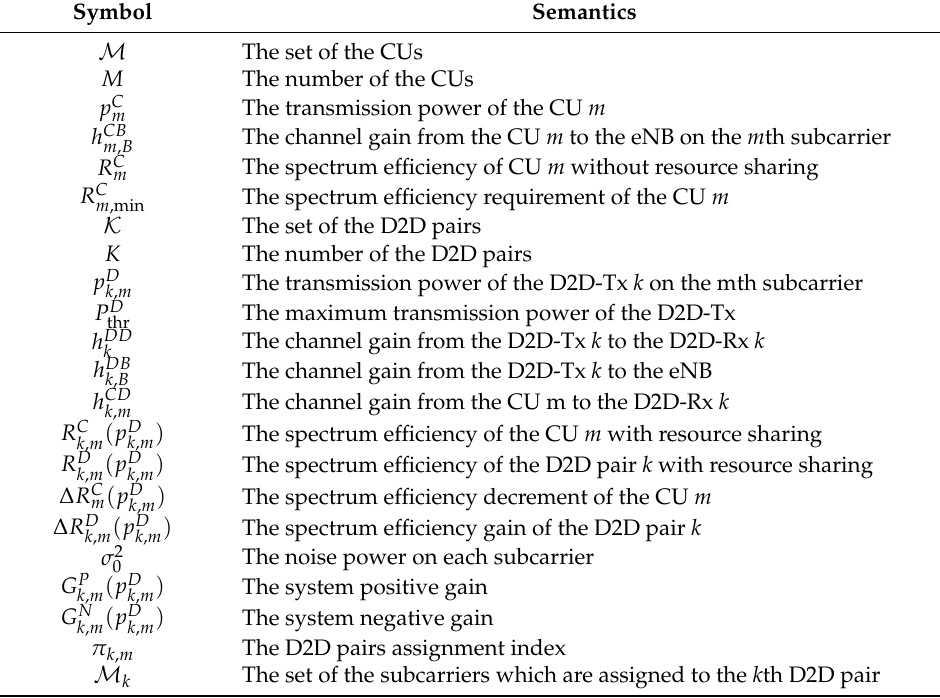
Table 1. Symbol Notations. CU, cellular users; eNB, evolved node B; D2D,